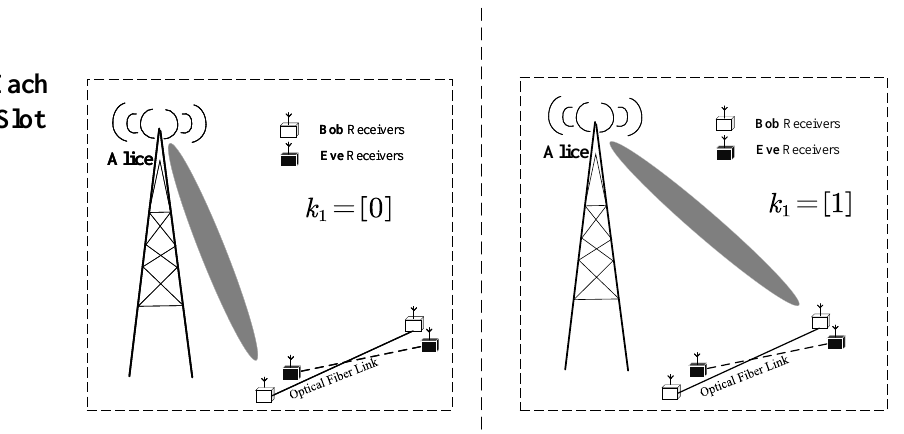
Figure 2. An example with N r = 2 for the traditional SDM activated process.